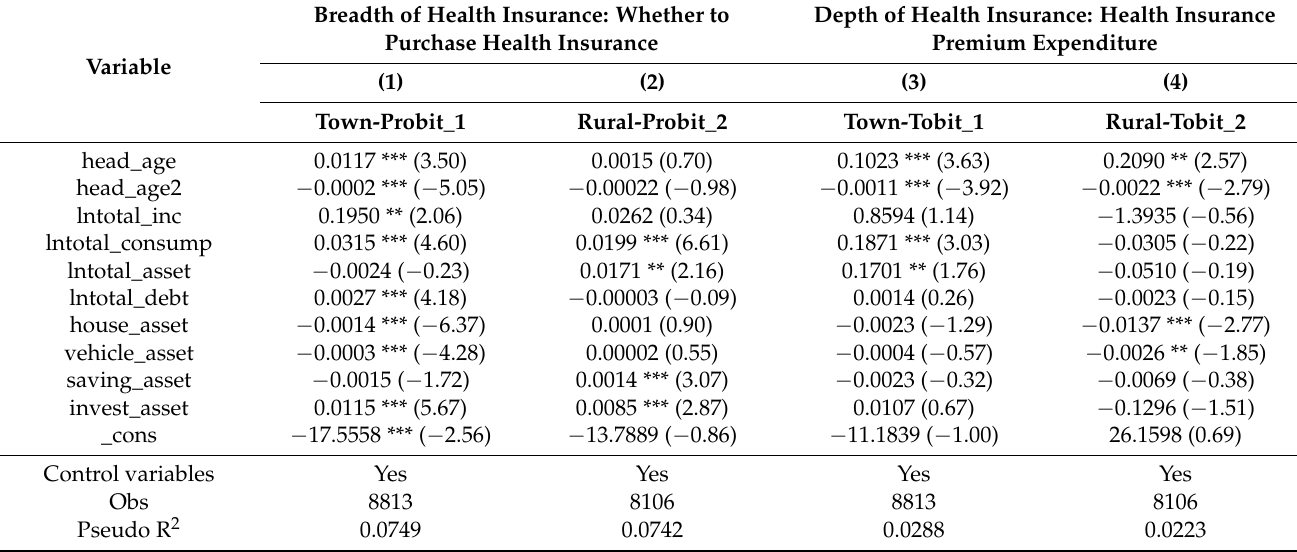
Table 9. Model estimation results under sub-samples divided by household registration type.